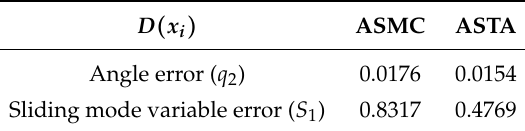
Figure 11. Comparison of the control torque in Case 2. Table 4. RMS errors in Case